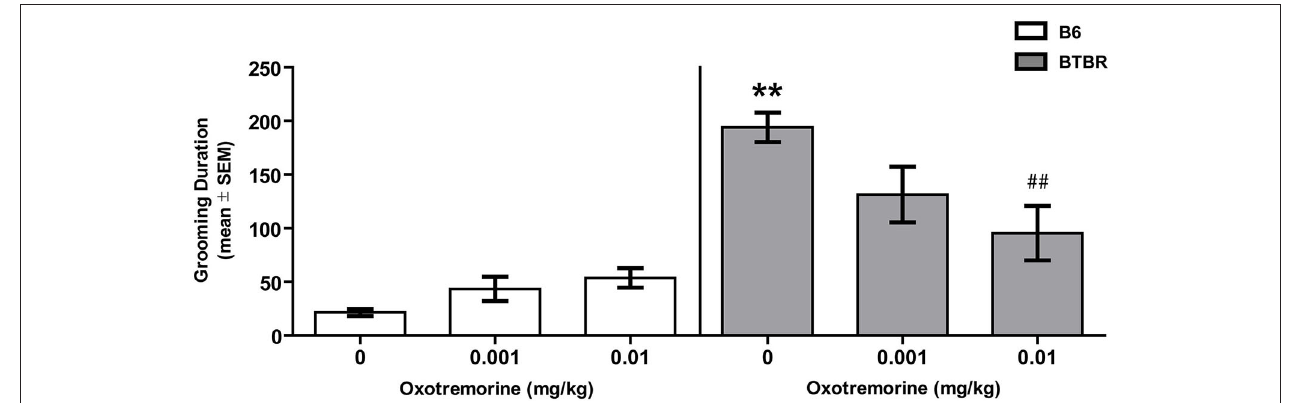
compared to that of B6 mice. Vehicle or oxotremorine treatment did not affect spontaneous grooming behavior in B6 mice. Oxotremorine at 0.01 mg significantly decreased spontaneous grooming in BTBR mice. B6: vehicle ( n = 8), 0.001 ( n = 8), 0.01 ( n = 8), BTBR: vehicle ( n = 9), 0.001 oxo ( n = 9), 0.01 oxo ( n = 9). ** p < 0.01 vs. B6-vehicle, ## p < 0.01 vs.